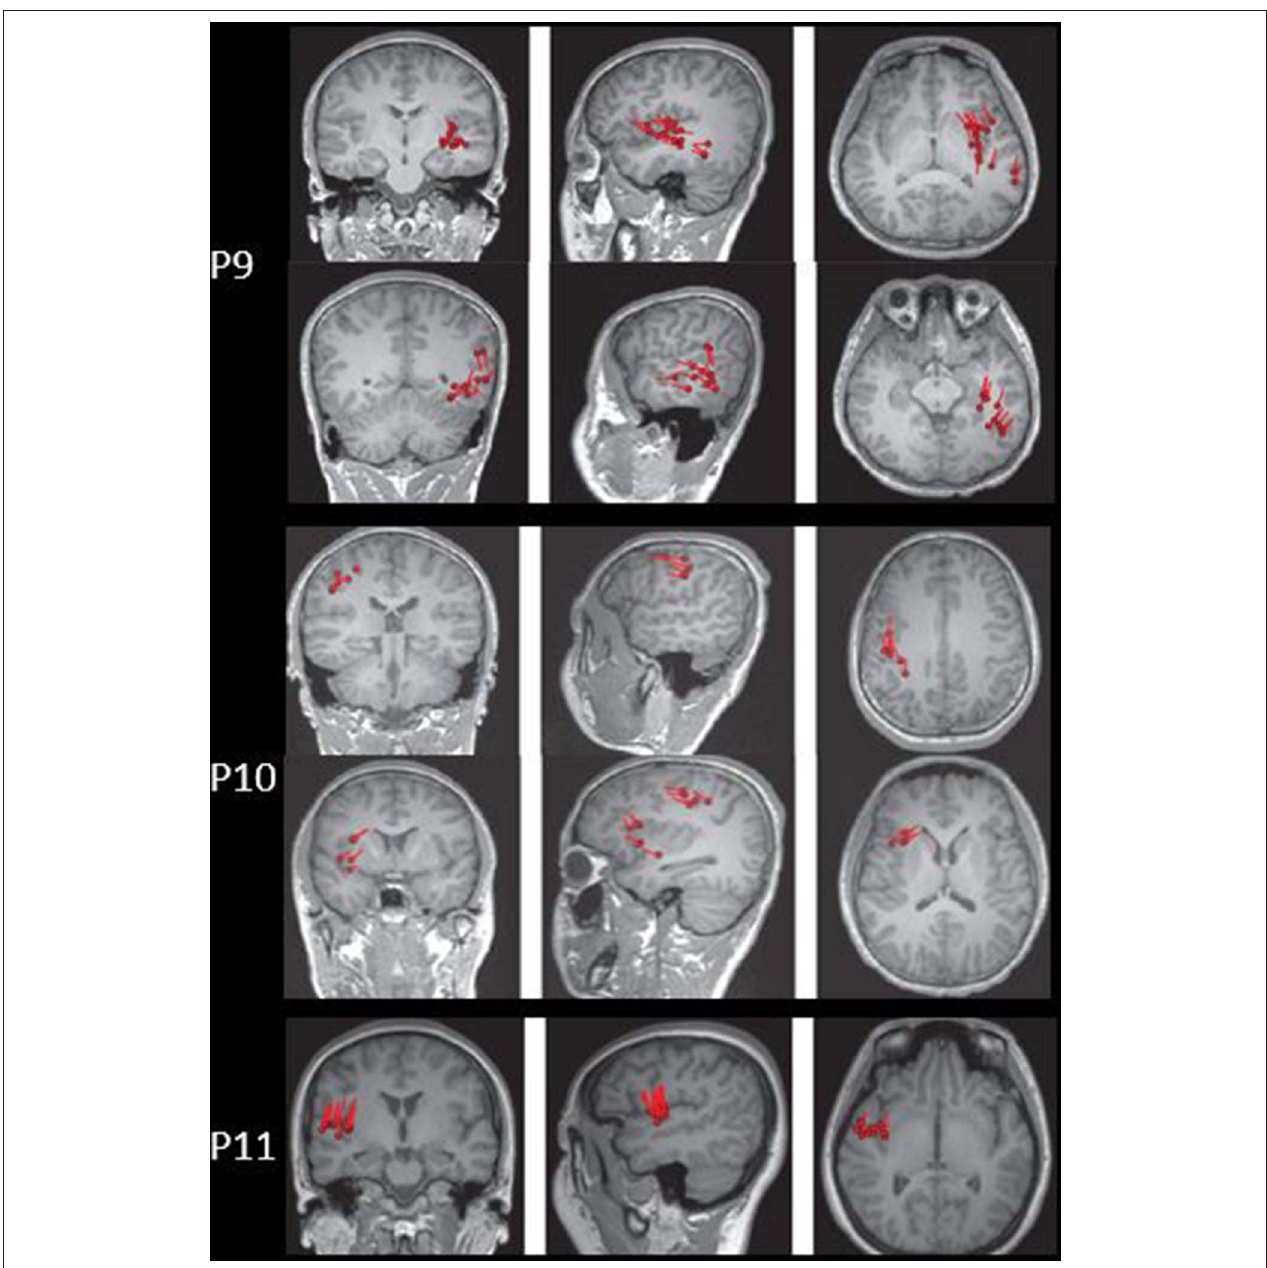
FIGURE 3 | The MEG results of Patient 9–11 in coronal, sagittal, and axial images.